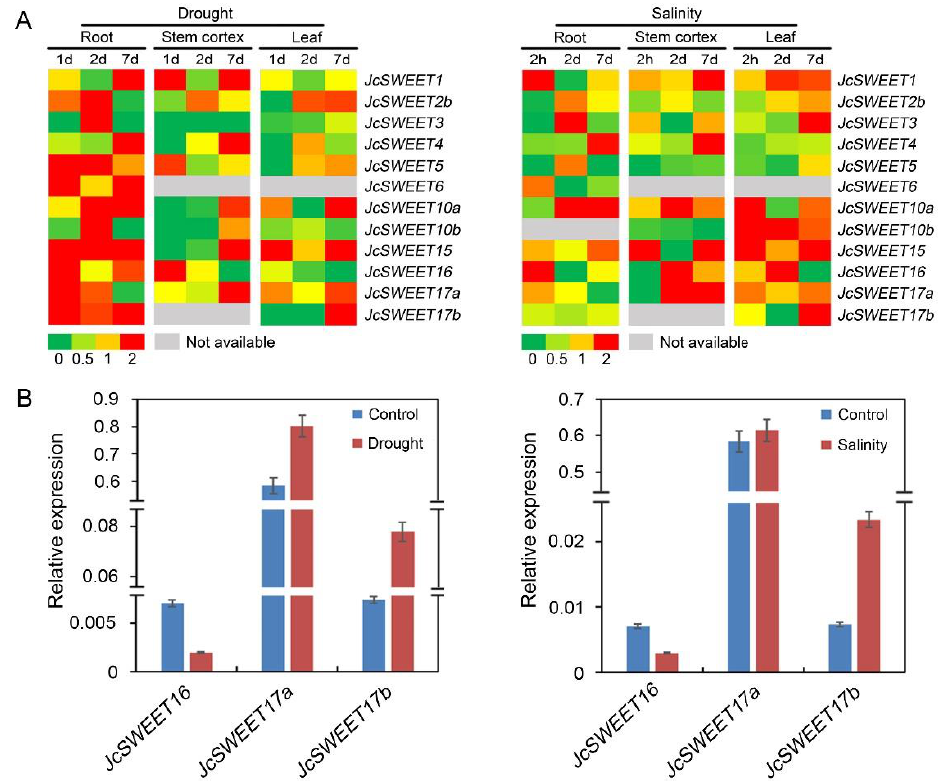
Figure 5. Expression patterns of JcSWEET genes in response to drought and salinity stresses. ( A ) Heatmap showing the expression levels of JcSWEET genes under drought and salinity stresses. Values presented in the heatmap are the ratios of stress treatment to control. ( B ) Expression levels of selected JcSWEET genes in leaves under drought and salinity stress at the 7 day point measured using qRT-PCR. Relative expression was normalized to that of the reference gene JcActin (internal control).